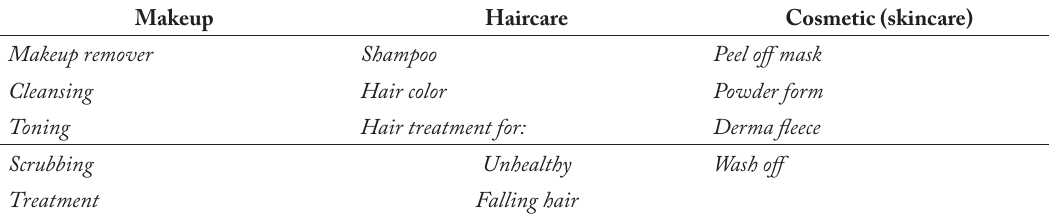
Table 2. Product Categories of Bays